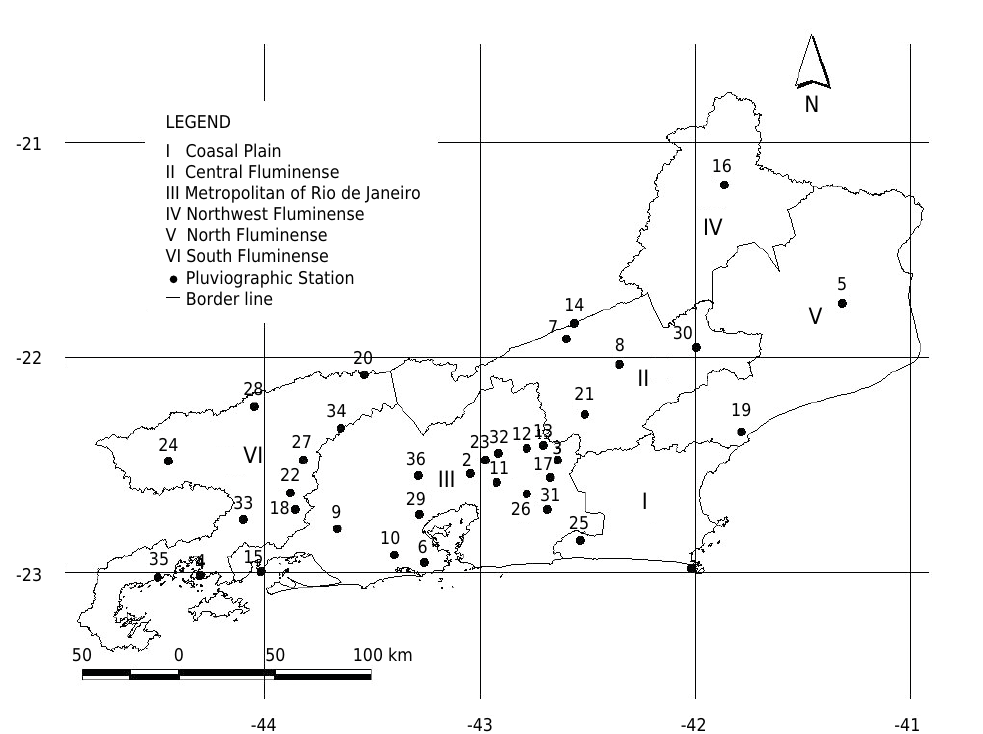
Figure 1. Location of the rainfall stations studied in the state of Rio de Janeiro,